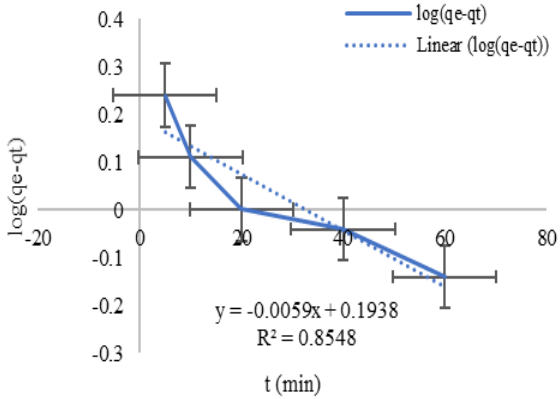
Fig. 7. First-order kinetics for removal of TNT in sono- Fenton process